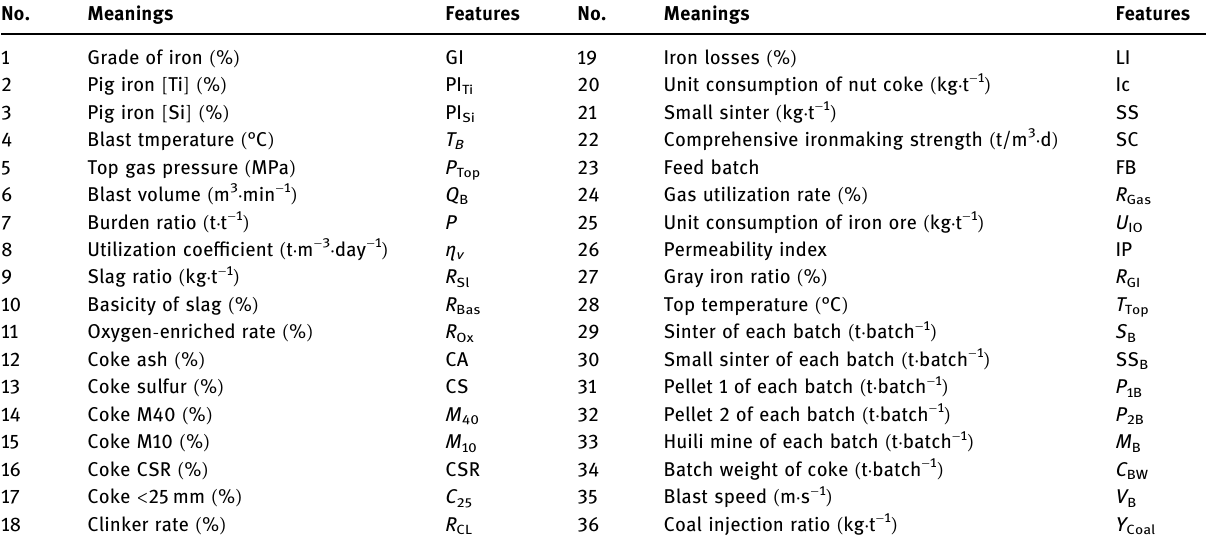
Table 1: The list of the independent